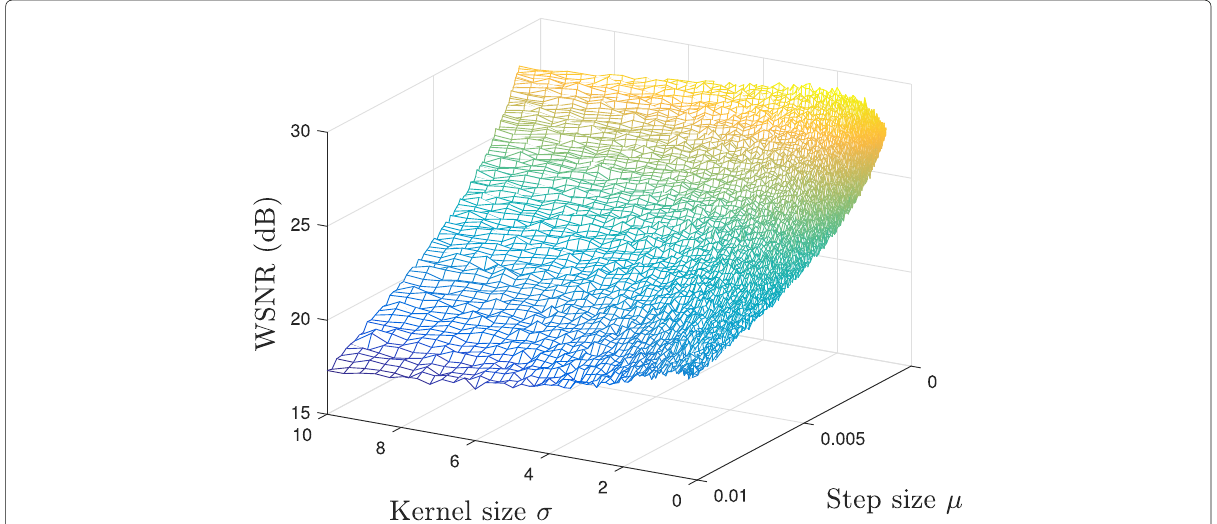
Fig. 7 WSNR performance of the SMCCC algorithm as a function of the kernel size parameter σ and the gradient step size μ . The noise environment is model by a stable distribution with α = 1.5 and GSNR = 20